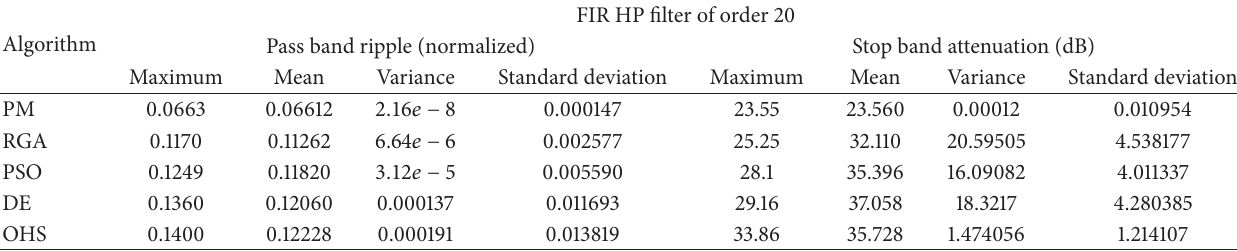
Table 12: Statistical parameters of FIR HP filters for different algorithms.